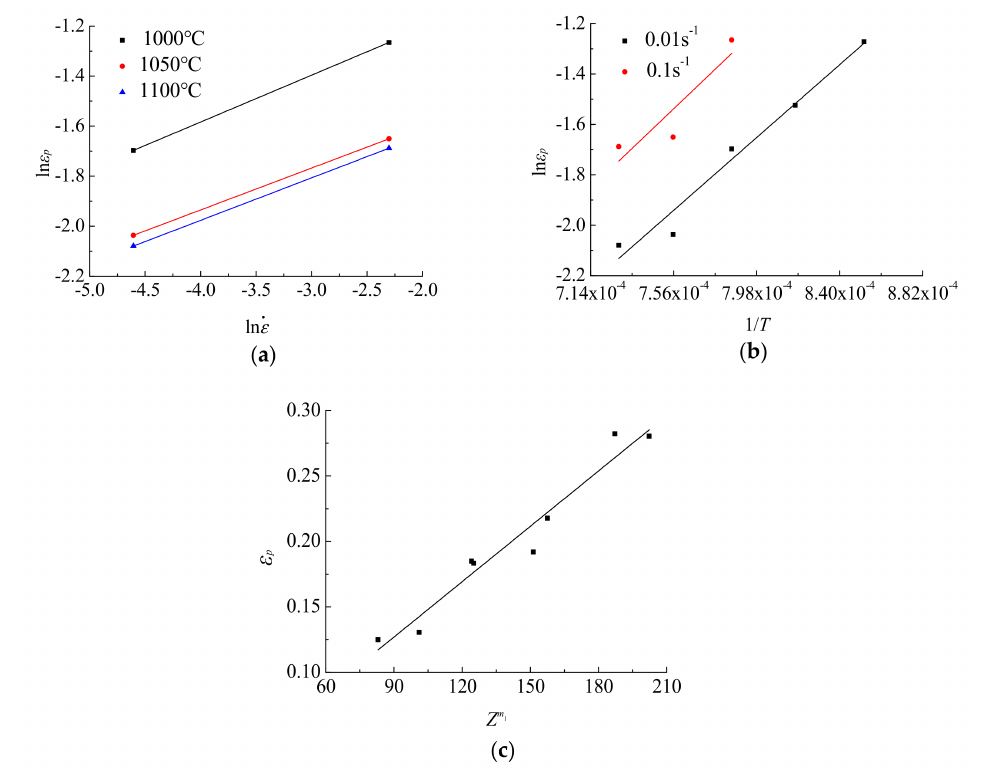
. ε ; ( b ) In ε p -1 / T ; ( c ) ε p - Z m 1